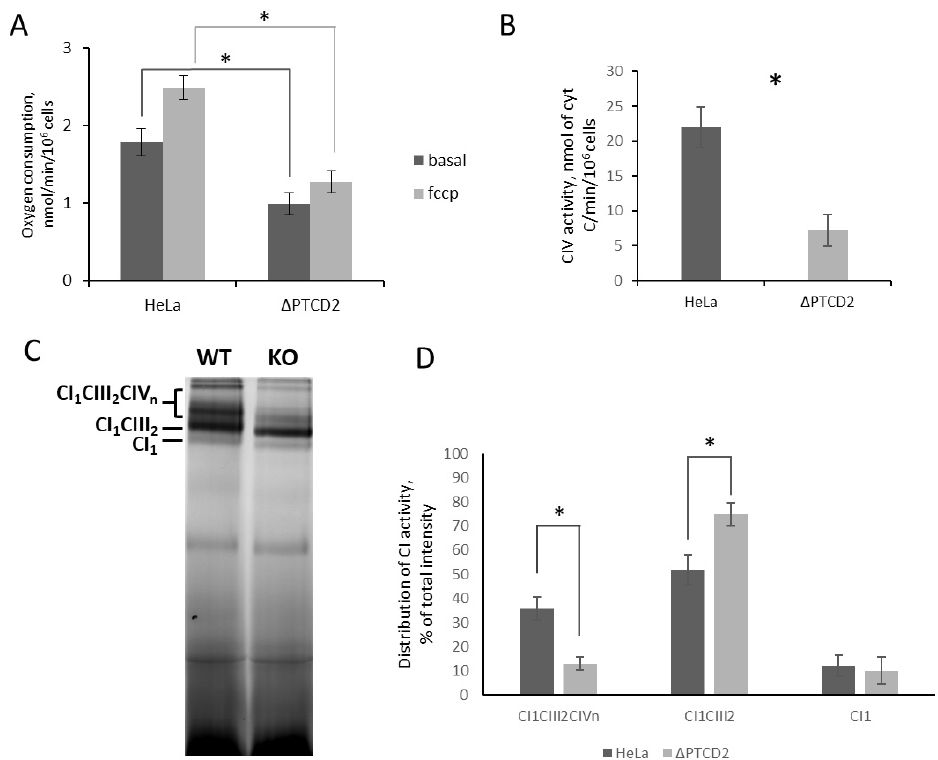
Figure 2. The absence of PTCD2 decrease mitochondrial fitness. ( A ) Oxygen consumption rates of wild-type HeLa and PTCD2 gene knock-out cells in the absence (basal) and the presence (fccp) of uncoupler reagent. Mean values ± SD are presented ( n = 6). ( B ) Activity of complex IV in HeLa and PTCD2 gene knock-out cells. Mean values ± SD are presented ( n = 4). ( C ) Blue-Native (4–10%) electrophoresis of mitochondria solubilized with digitonin. Gel was stained for complex I activity as described in Materials and Methods. Stoichometrical composition of resolved supercomplexes shown, WT—wild-type HeLa mitochondria, KO— PTCD2 gene knock-out mitochondria. ( D ) distri- bution of CI activities between supercomplexes ( n = 4). *— p -value < 0.05 by Student’s test.